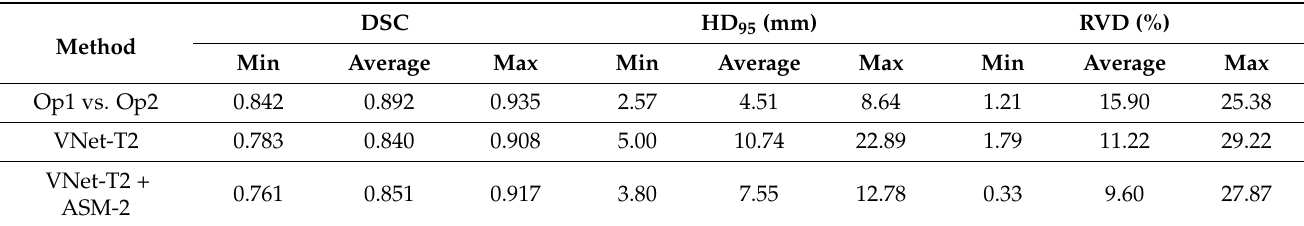
Table 5. Minimum, mean, and maximum values of metrics in the test set compared with inter-operator variability (Op1 vs. Op2).